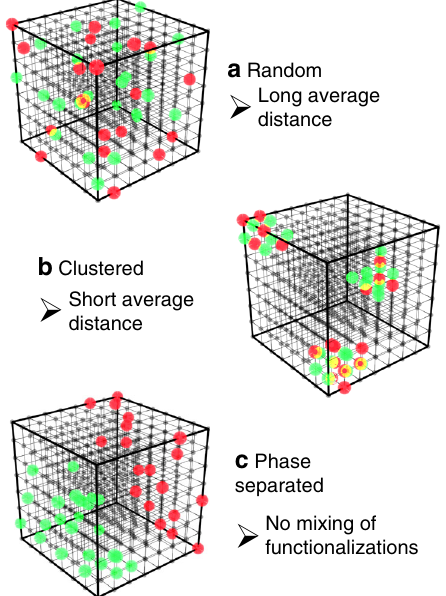
Fig. 1 Schematic representation of the possible spatial distributions of two different functionalities within the MOF structure. a A random distribution with a long average separation between functional groups, green and red. b A clustered distribution with short average distances between functional groups. A sub-form of clustering is a distribution at or close to the surface. c A phase-separated distribution with very long distances between different functional groups. In the different phases, the individual groups themselves can be both clustered or